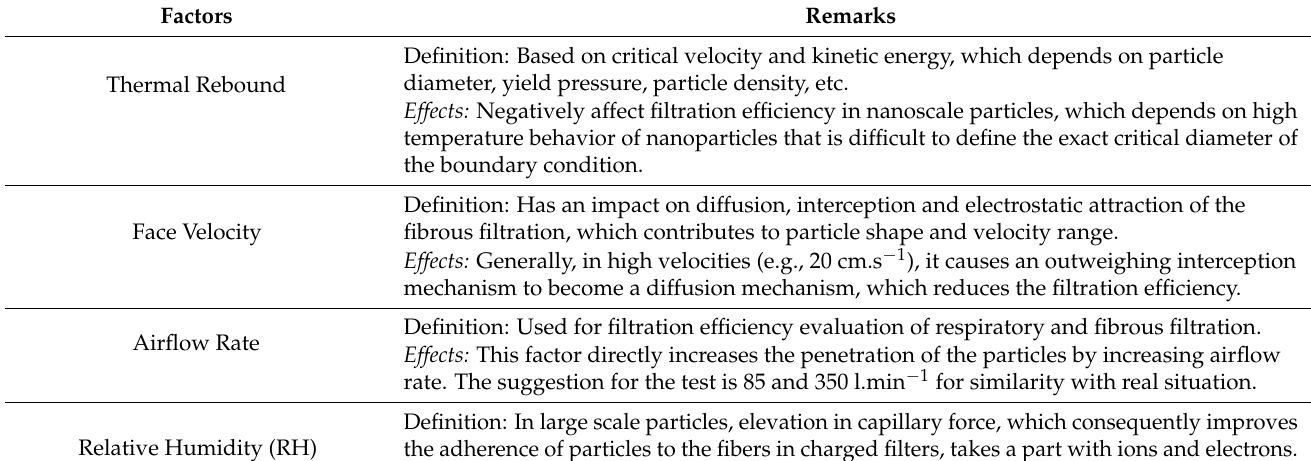
Table 6. Test parameters and details of related roles in filtration efficiency